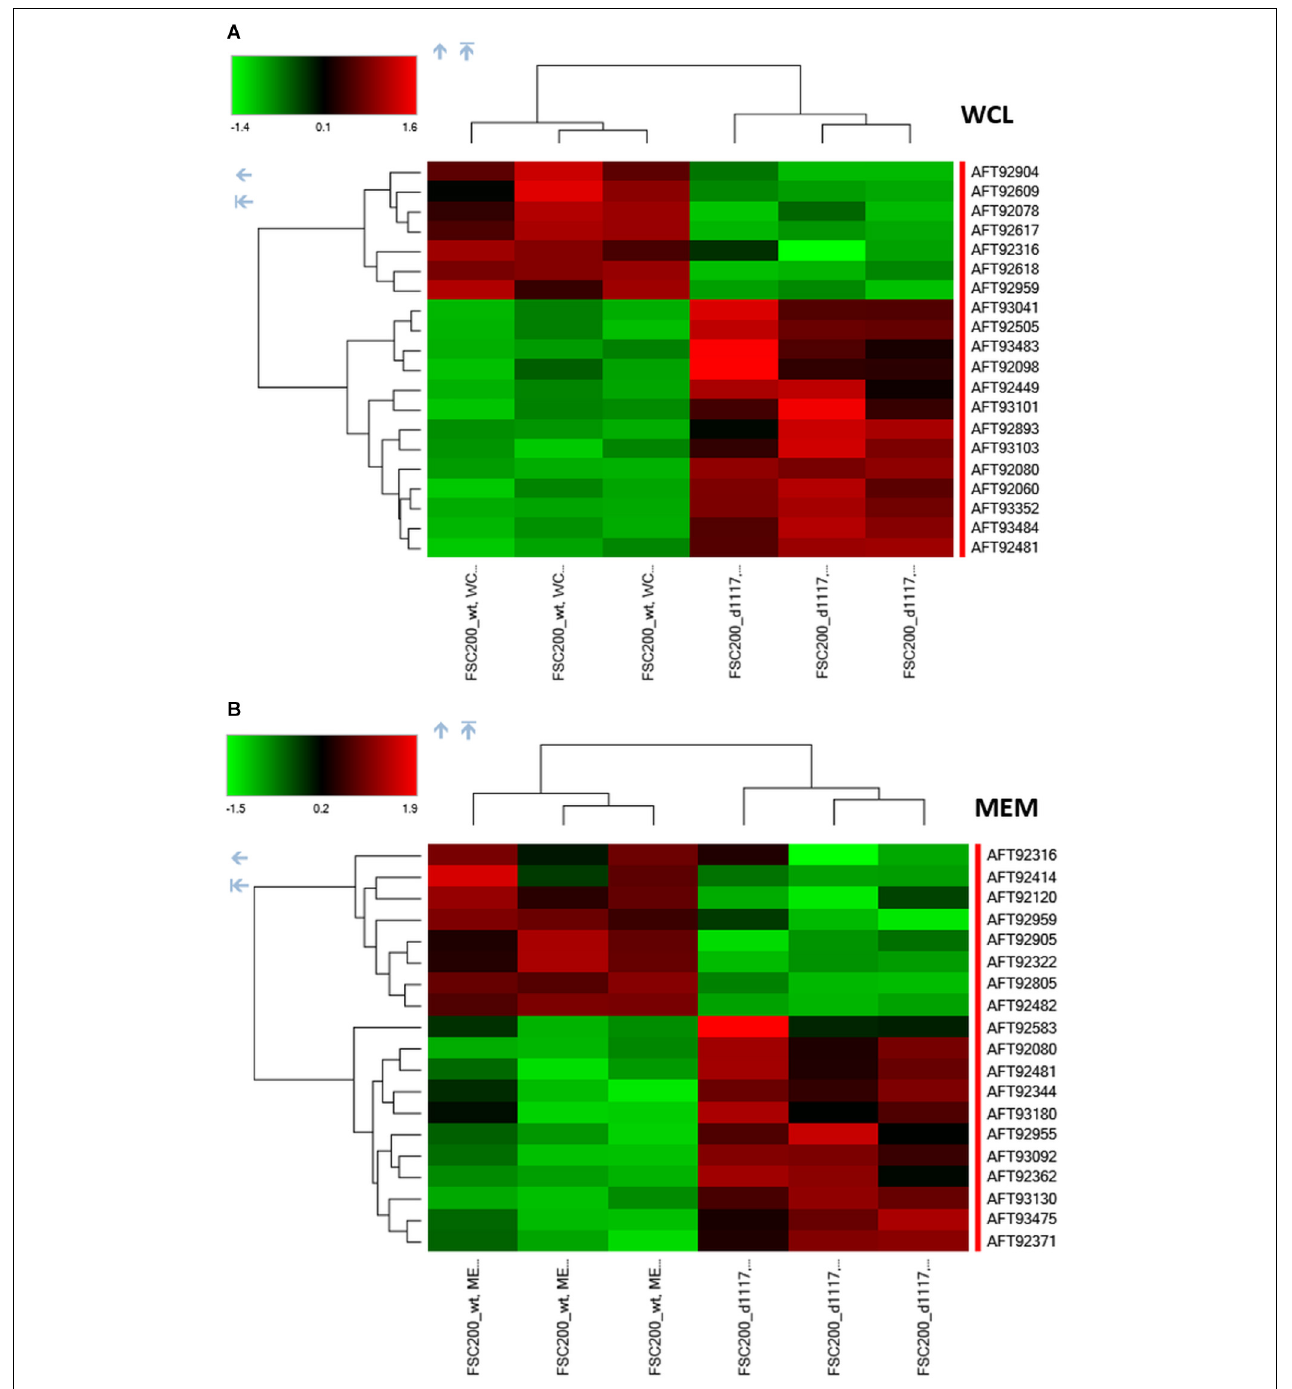
FIGURE 6 | Biclustering and heat maps of proteins differentially expressed and identified from label-free MS analysis of whole-cell lysates (A) and crude membrane fractions (B) of wt FSC200 and (cid:49) gapA strains.